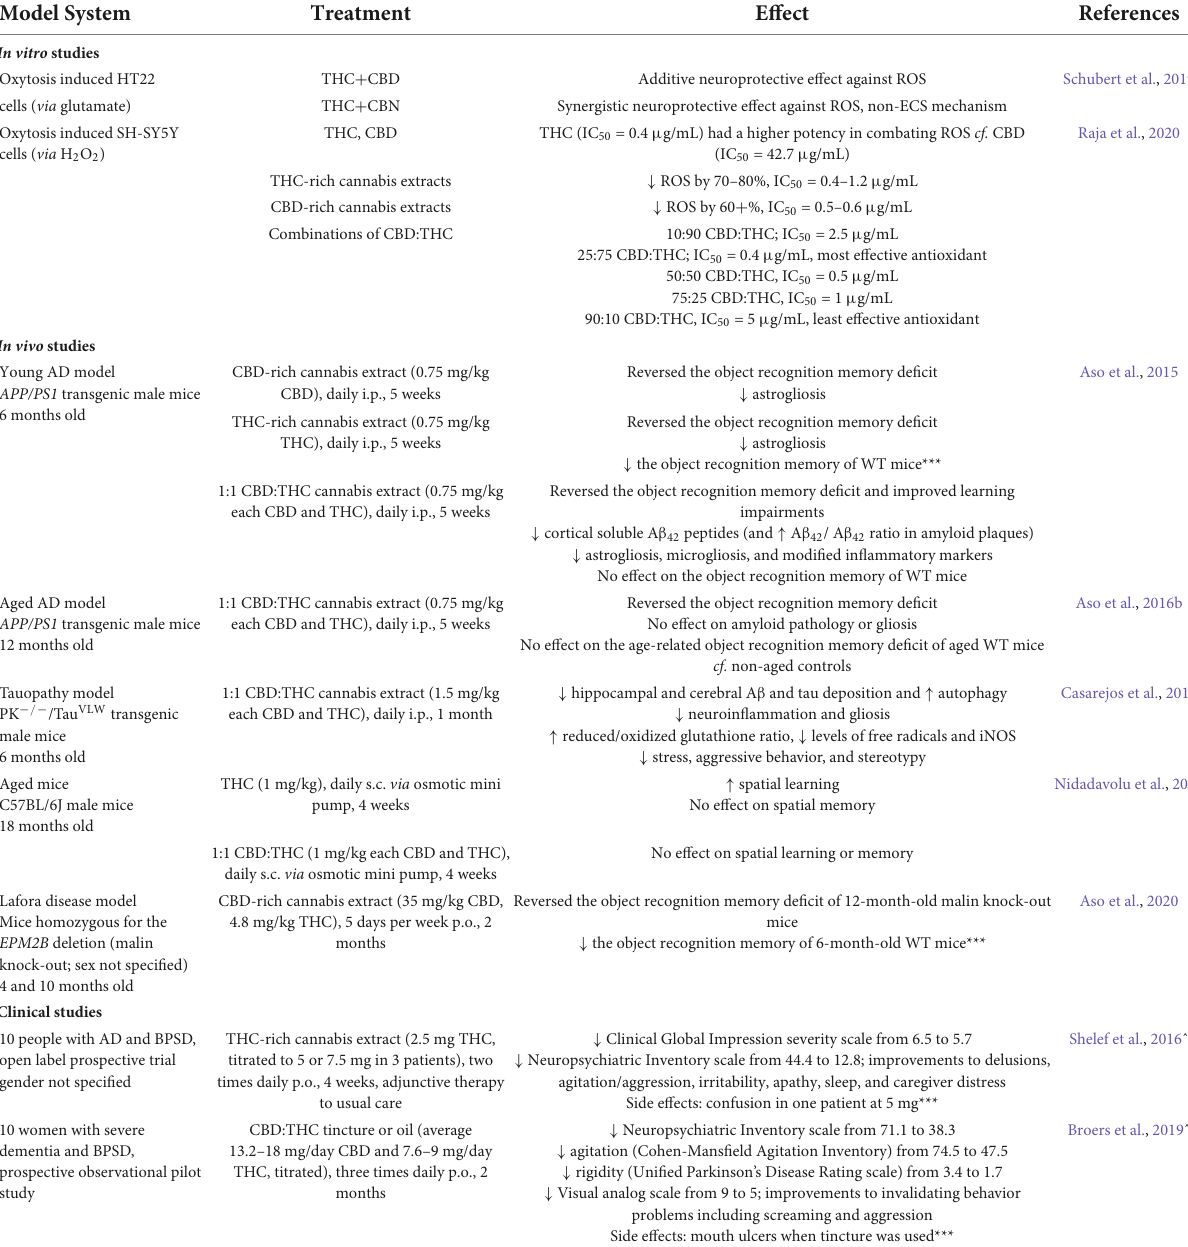
TABLE 1 Summary of the effects of CBD:THC cannabinoid combination treatments in AD-relevant cell and animal models as well as in people with AD from clinical studies. Model